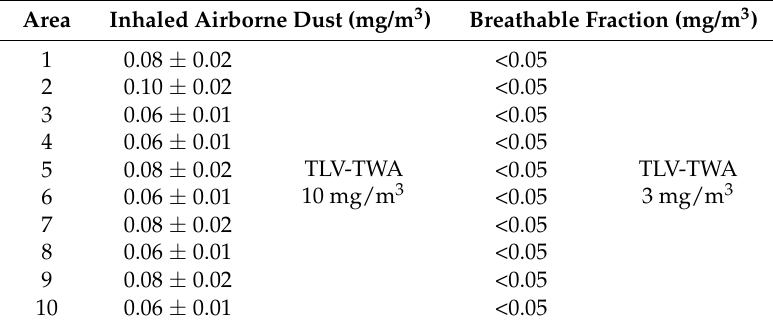
Table 2. The environmental